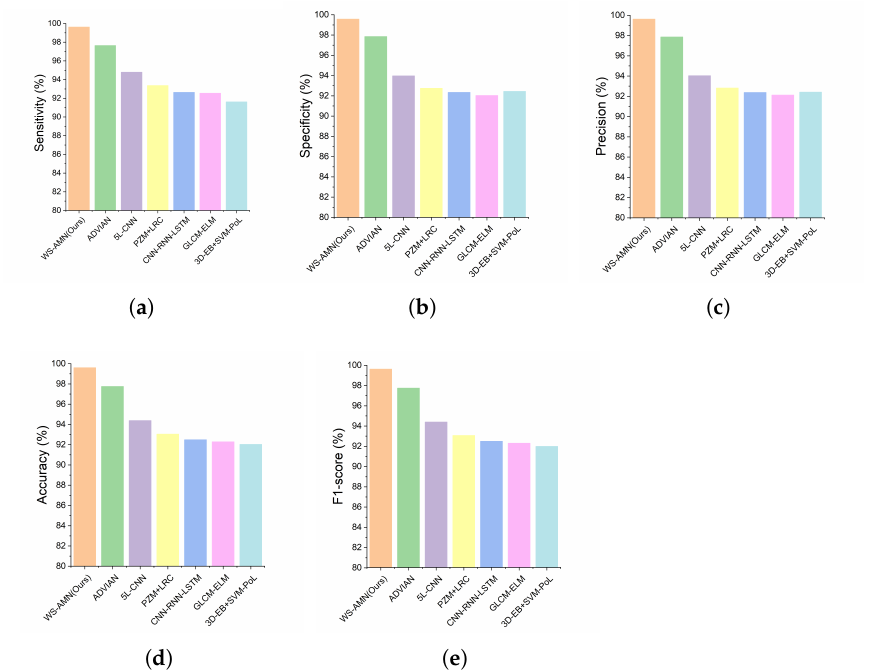
Figure 10. Comparison of the ( a ) sensitivity, ( b ) specificity, ( c ) precision, ( d ) accuracy and ( e )